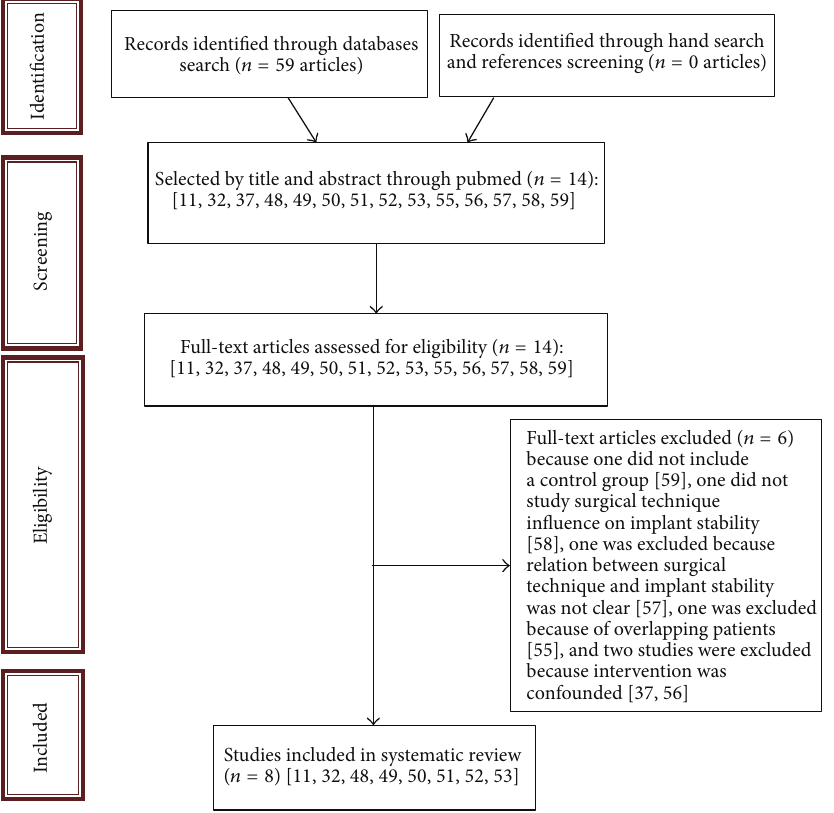
Figure 1: Flow diagram of literature